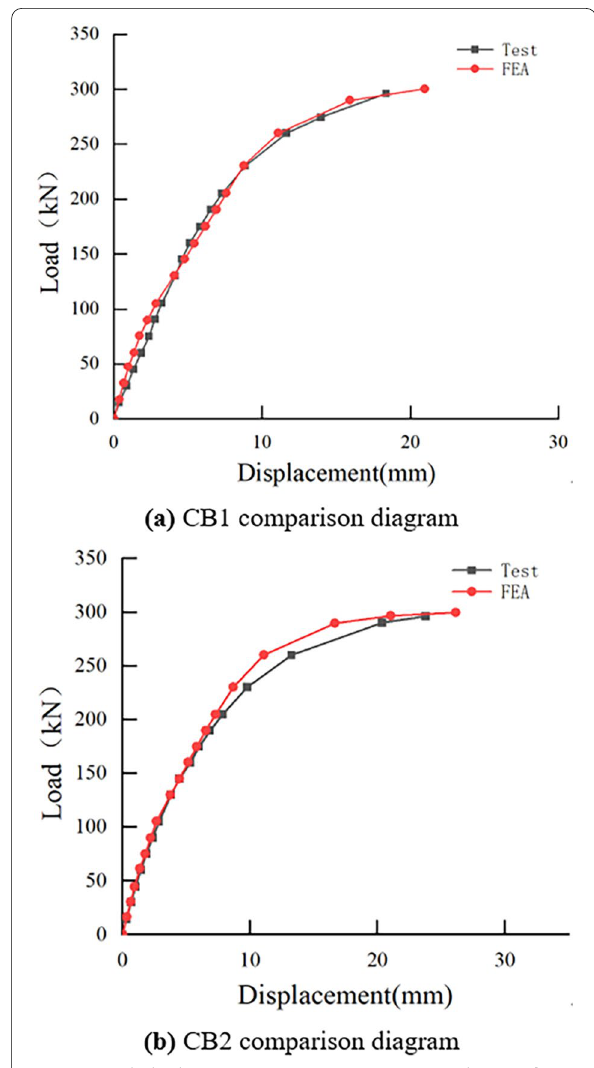
Fig. 12 Load–displacement curve: a CB1 comparison diagram, b CB2 comparison diagram